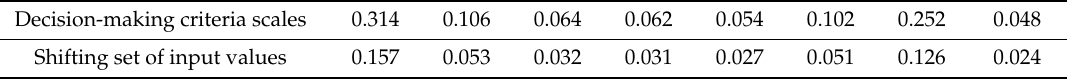
Table 1. The shift value in accordance with the adopted methodology is half of the importance of the decision criteria. Table 4. Decision-making criteria scales and shifting set of input